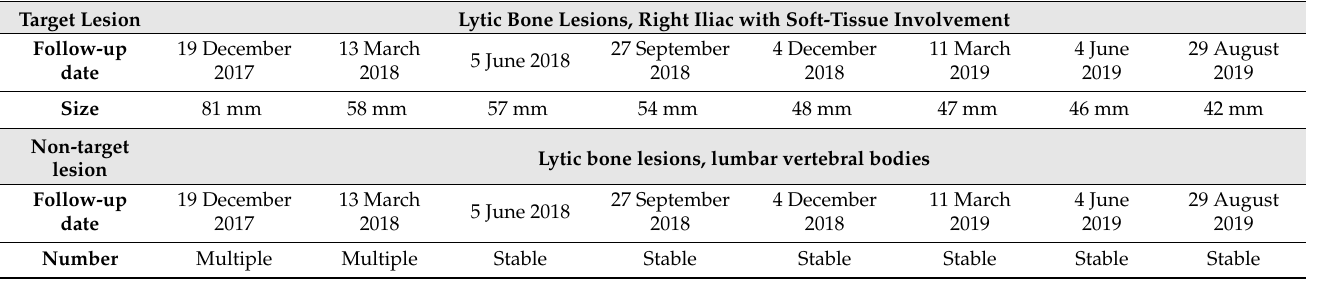
Table 1. Lesions follow-up according to the RECIST 1.1